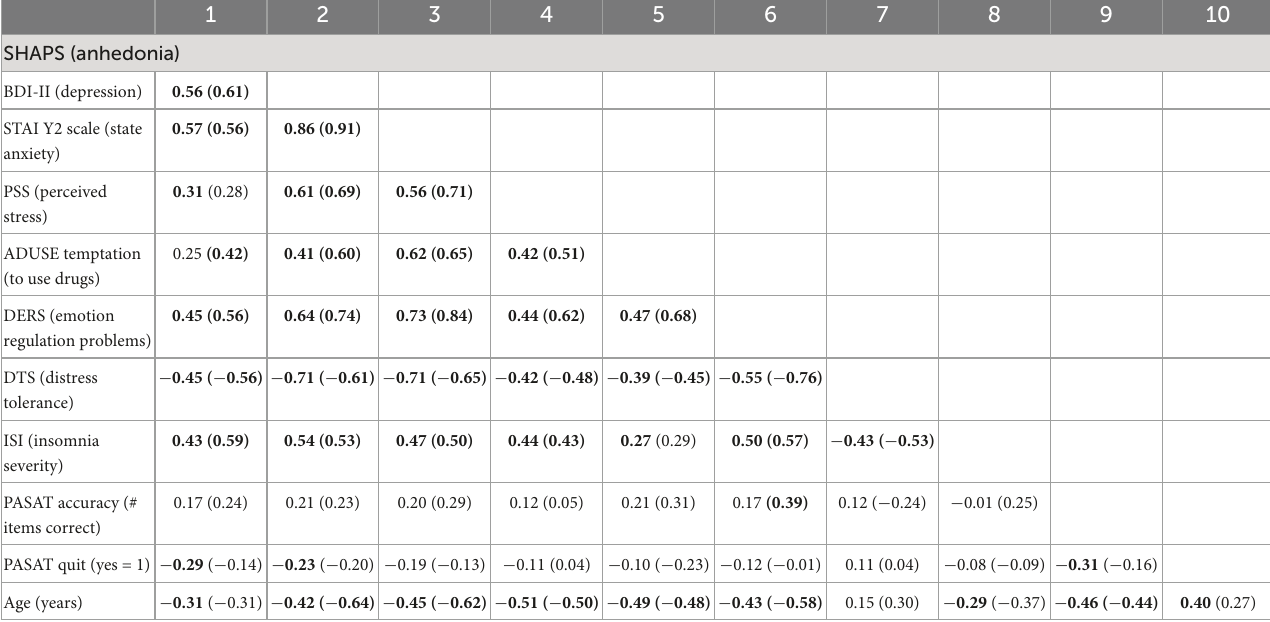
TABLE 3 Correlations between selected measures of affective dysregulation, insomnia severity and age in the overall sample ( N = 59), and in parentheses, the subgroup of lifetime benzodiazepine misusers ( n =